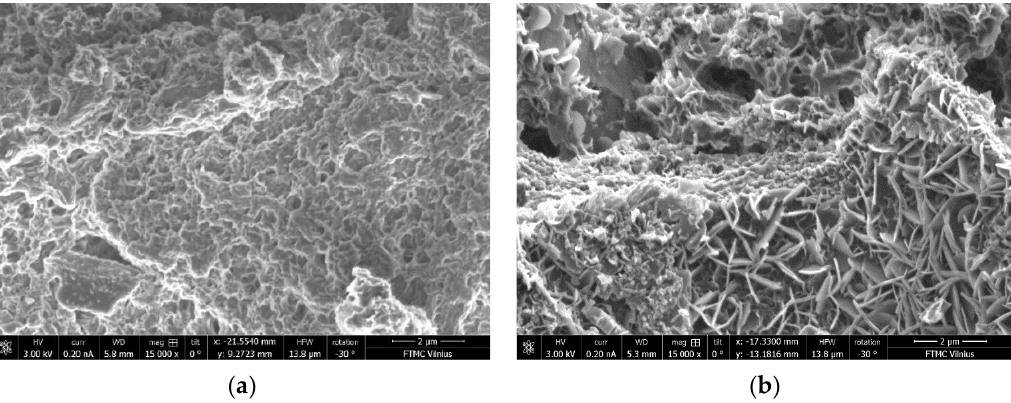
Figure 20. Microstructure of the samples cured at 40 °C: ( a ) CS-0.40-40; ( b ) CS-1.20-40 (magnification 15,000).